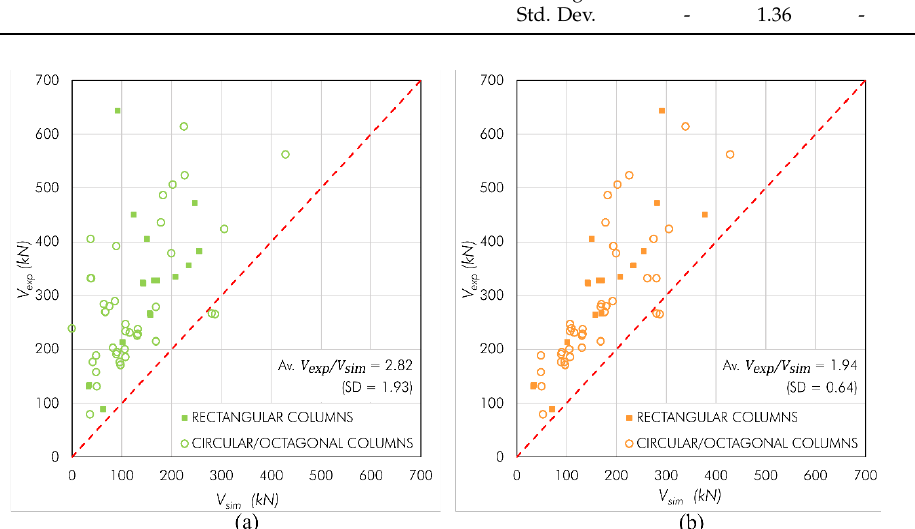
Figure 3. Shear strength predictions of rectangular, circular, and octagonal columns using the AASHTO Simplified Procedure: ( a ) With reduction in 𝑉 𝑐 for low axial load levels; ( b ) Without reduction in 𝑉 𝑐 .